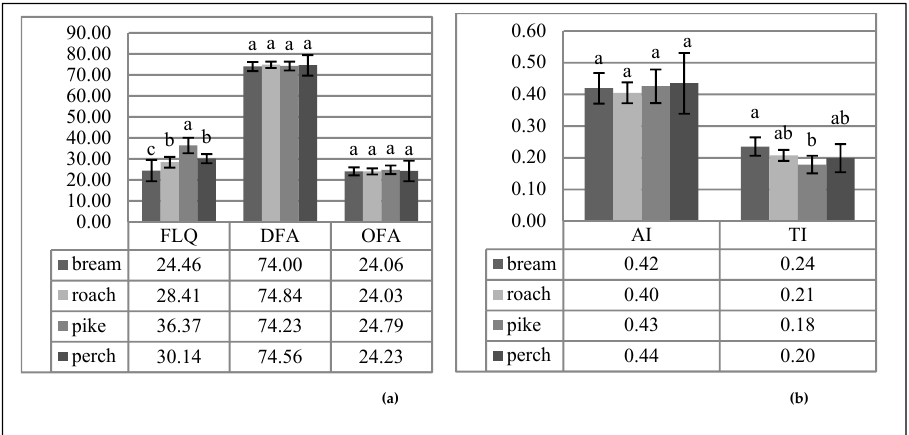
Figure 6. Lipid quality indexes. ( a ) Flesh-lipid quality (FLQ); hypercholesterolaemic fatty acids (OFA); hypocholesterolaemic fatty acids (DFA); ( b ) index of atherogenicity (AI); index of thrombogenicity (TI); a, b, c—significant di ff erences between the fish of the di ff erent species ( p ≤ 0.05). The same letter indicates the absence of significant di ff erences ( p >